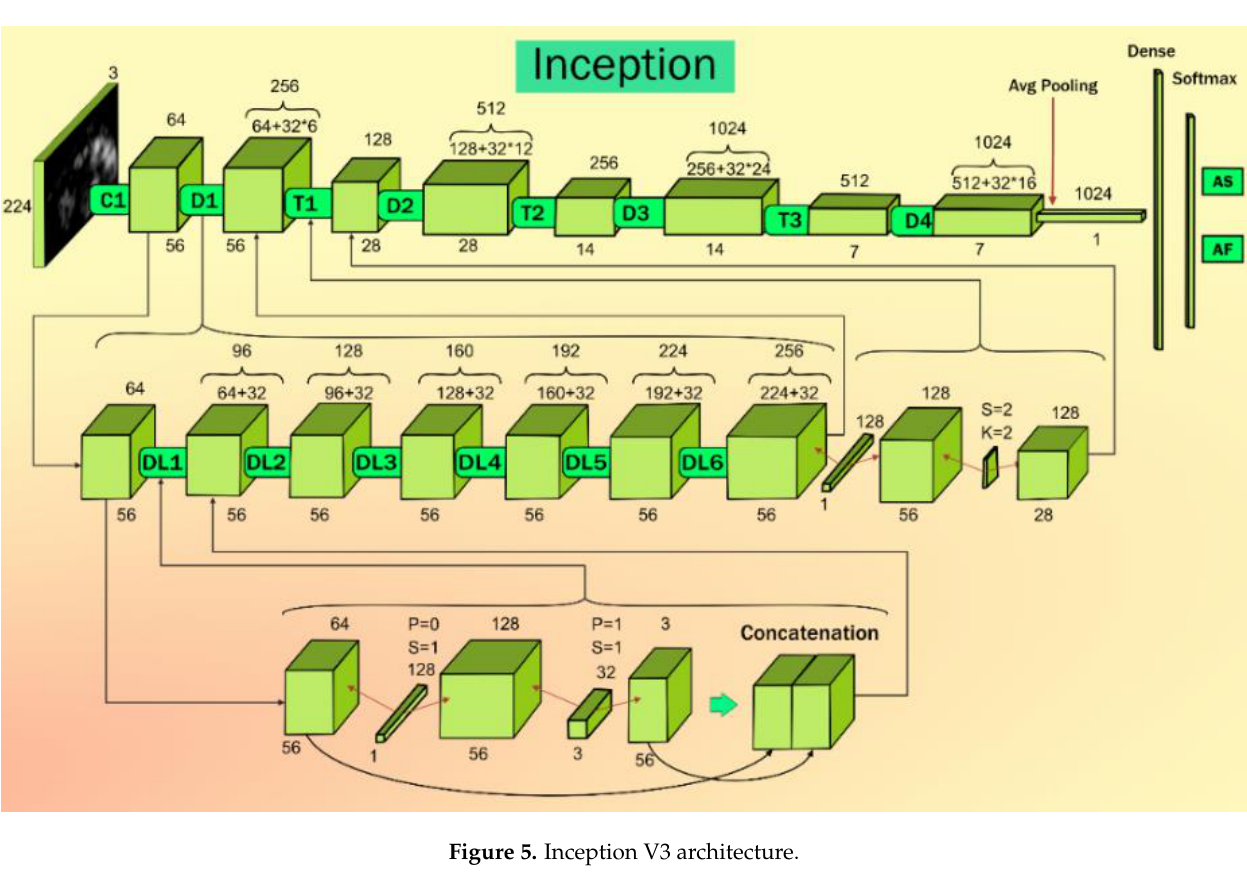
Figure 5. Inception V3 architecture.